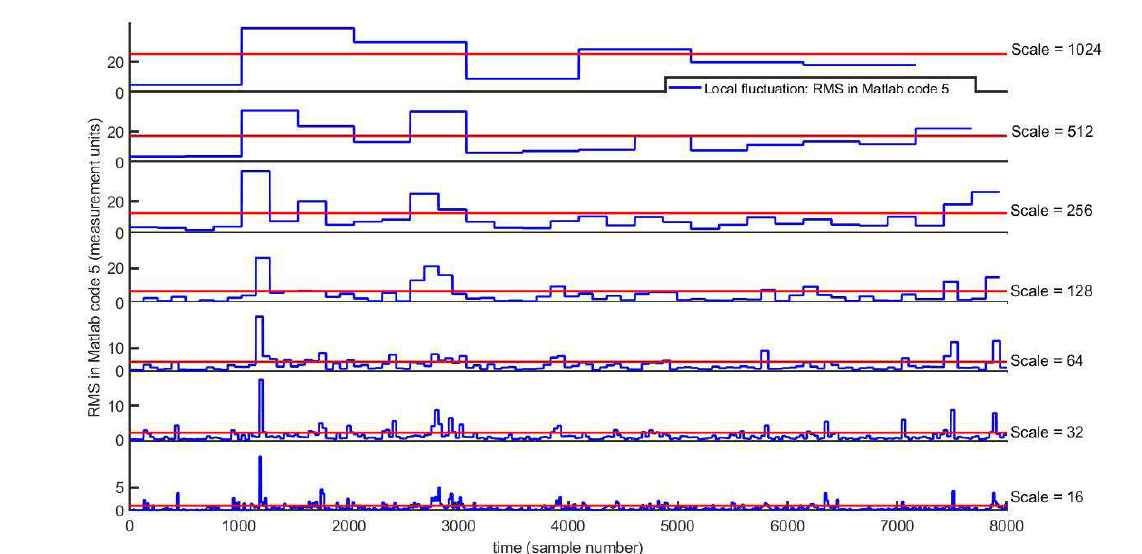
Figure 3. Root mean square